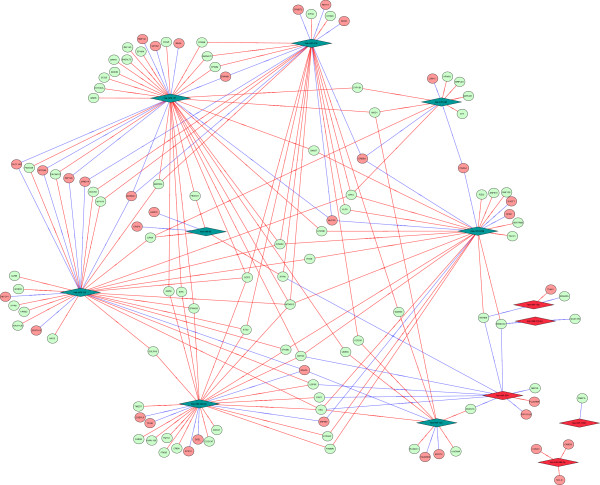
miRNA-mRNA correlation network. miRNA-mRNA correlation network discovered by SA-BNs, rendered in cytoscape [39]. In this network, the miRNAs are demonstrated by diamond shape while mRNAs with circles. Upregulated miRNA are in red, while downregulated miRNA are in green. Upregulated mRNAs are in pink, while downregulated are in light green. The positive correlated miRNAs and mRNAs are connected by red line, while the negative correlations by blue lines.